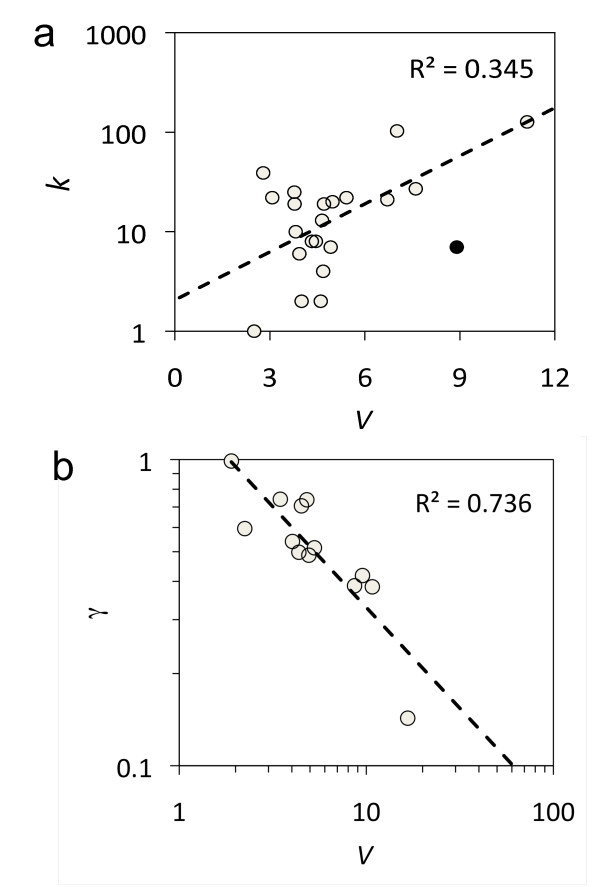
Functionality of sncRNAs. (a) Scatter plot between the connectivity degree of the sncRNAs (k) and degree of functionality (V). The outlier (black point) corresponds to gene sgrS, which is a particular sncRNA that also codifies for a small polypeptide (43 amino acids). (b) Scatter plot between degree of functionality (V) and γ, which is the slope of the linear regression between the mutational and environmental robustness for all sequences that have a common structure. For this plot, a representative subset of sncRNA structures was considered (genes C0293, C0664, dsrA, ffs, gcvB, glmY, micA, oxyS, psrN, rydC, ryhB, sokC, and ssrA).